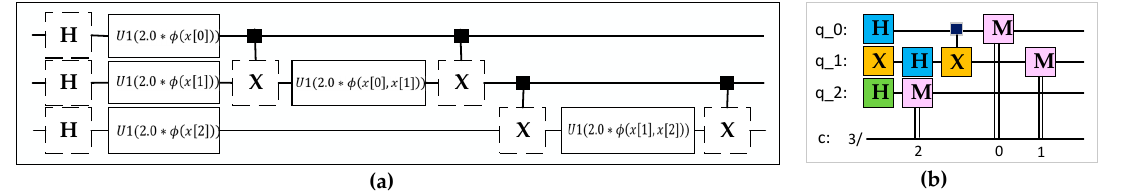
Figure 3. ( a ) ZZFeatureMap architecture. ( b ) A quantum circuit model.